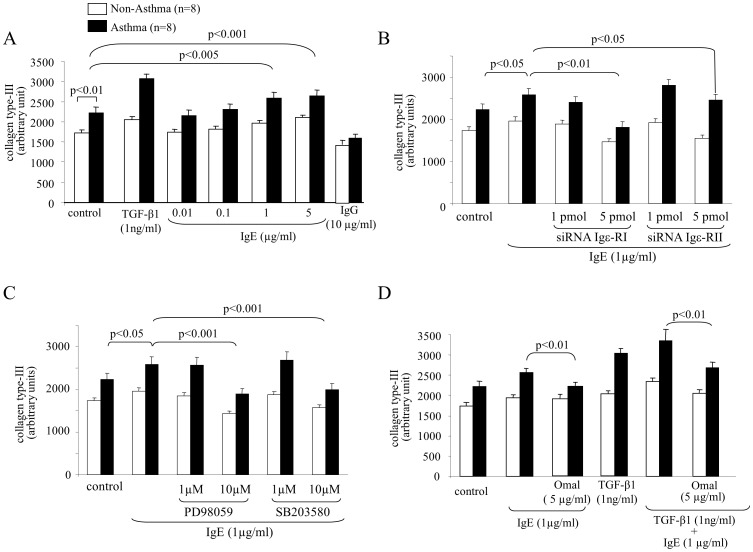
Collagen type-III deposition by IgE is regulated through the Igε-RI and Erk1/2 and p38 MAPK.(A) Induction of collagen type-III deposition by IgE by ASMC and (B) the mediator role of Igε-RI and Igε-RII. (C) Contribution of MAPK to Igε-RI and Igε-RII signalling on IgE induced collagen type-III deposition by ASMC. (D) Specificity of IgE neutralising antibody treatment on combined TGF-β1 and IgE collagen type-III deposition by ASMC.